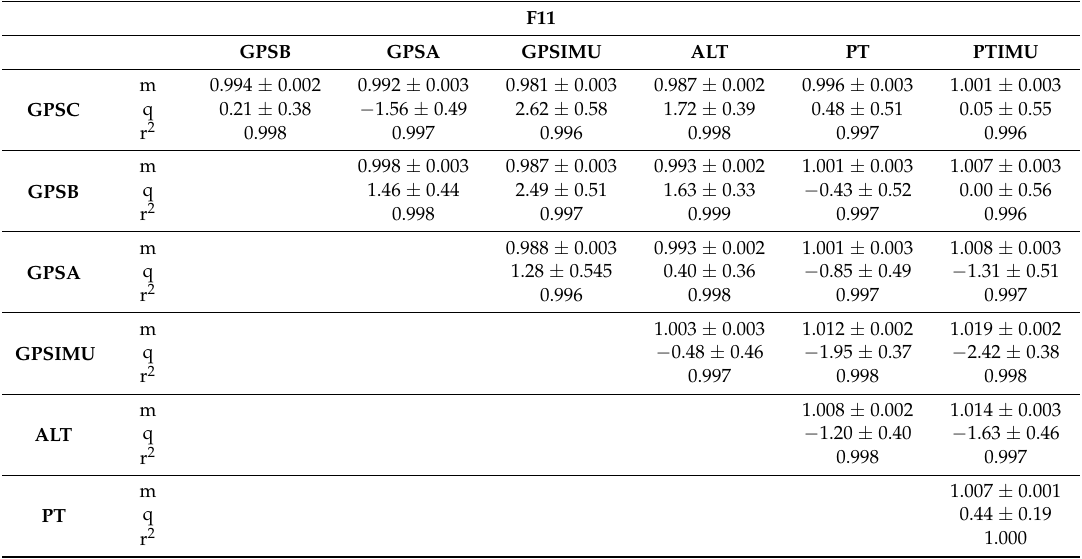
Table A1. Linear regression data of F11 (DATASET 2 α ).